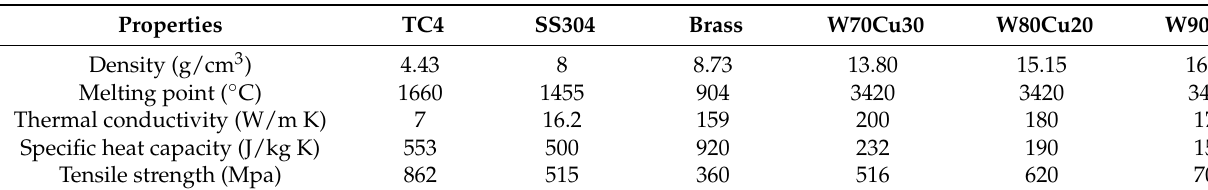
Table 1. Properties of the electrode materials.